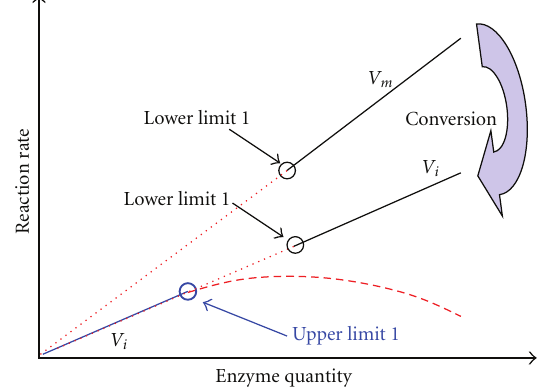
Figure 1: Conversion of V m into initial rate ( V i ) to meet the second prerequisite for an integration strategy to quantify an